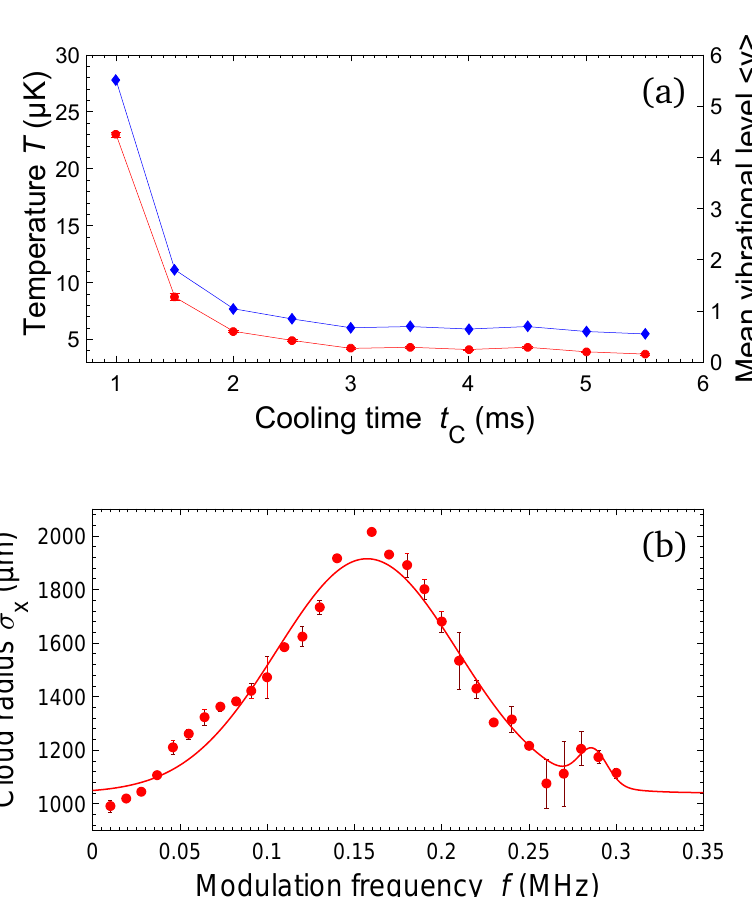
Figure 4: (a) Dependence of the temperature T (red circles) and mean vibrational level 〈 ν 〉 (blue diamonds) on the cooling duration t . After 5 ms of cooling, we reach C a temperature of 4 µ K. A polarizer intensity of 2.9 mW / cm 2 corresponding to 115 µ W of power is used. (b) Parametric excitation spectrum obtained by modulating the lattice intensity by 26% for 5 ms at a frequency f . We observe resonant heating, corresponding to an increased cloud radius, when the modulation frequency matches twice the trap frequency. The data is fitted to a double Gaussian function, which = yields centre frequencies of 160 and 277.5 kHz. We use a total lattice power P L 80 mW. Detunings are indicated in Fig. 3. Error bars indicate standard deviations in both (a) and